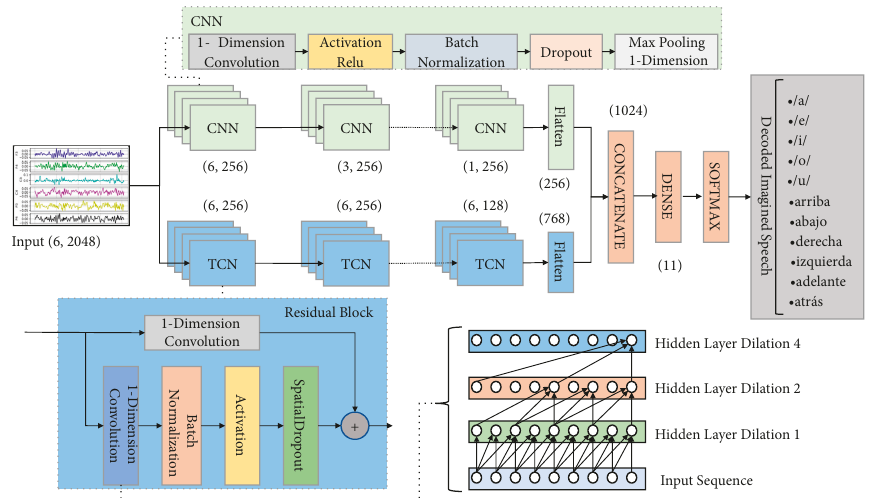
Figure 3: The proposed deep learning model architecture is depicted in the diagram.